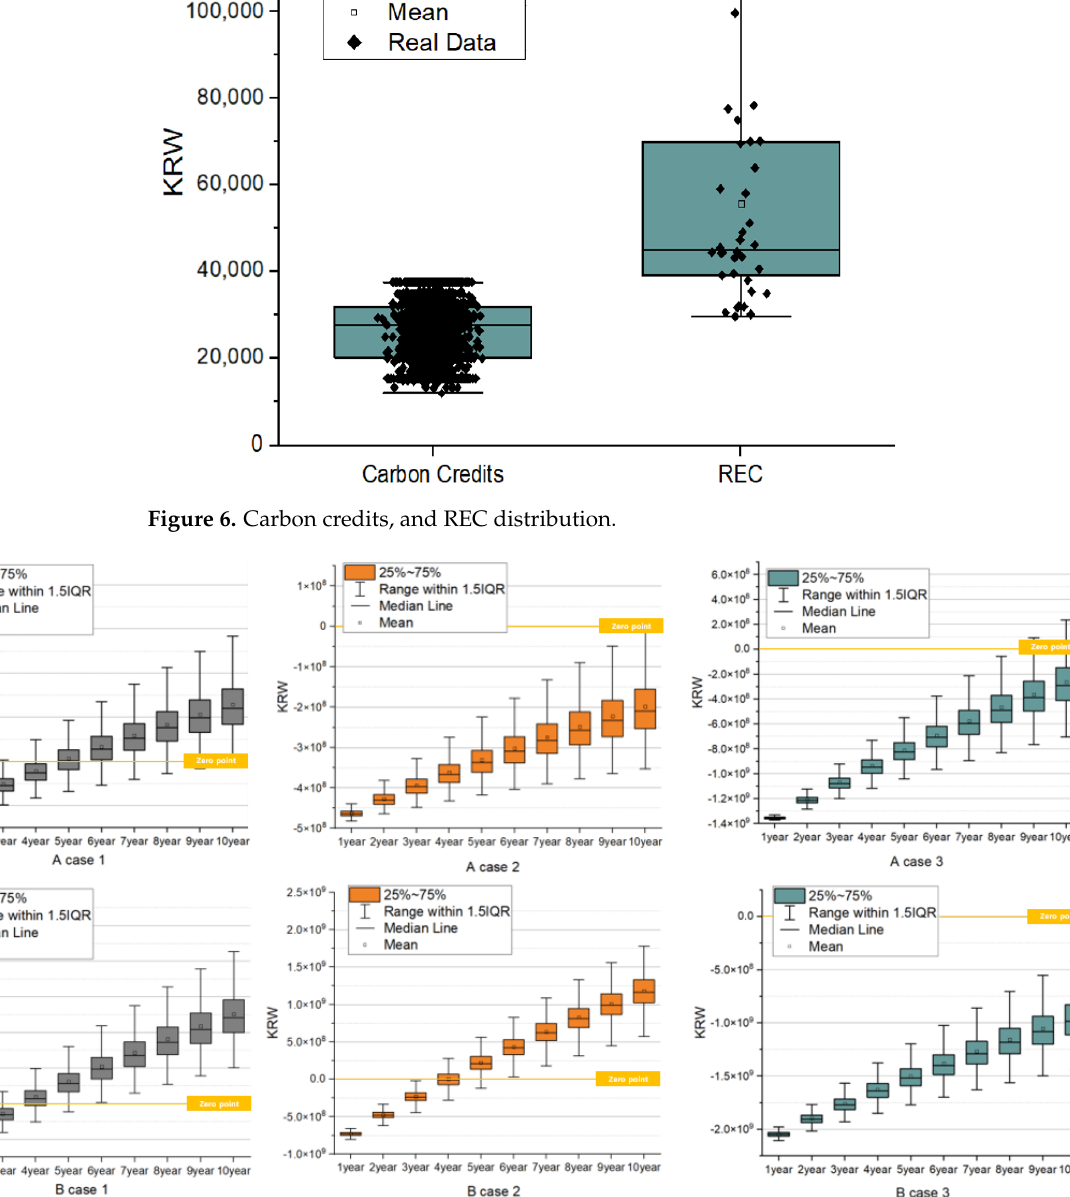
Figure 7. NPV simulation box chart results: (A case 1) Facility A case 1, (A case 2) Facility A case 2, (A case 3) Facility A case 3, (B case 1) Facility B case 1, (B case 2) Facility B case 2, (B case 3) Facility B case 3. Table 8. NPV simulation median value results.